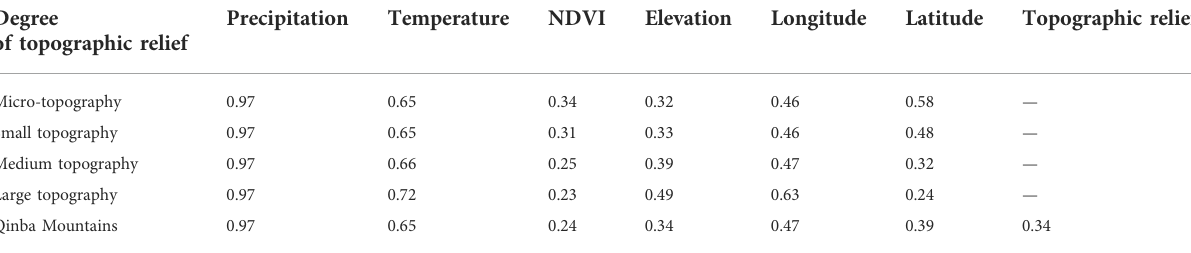
TABLE 2 Statistical results of q values of in fl uencing factors of rainfall erosivity in Qinba Mountains. Degree Precipitation Temperature NDVI Elevation Longitude Latitude Topographic relief of topographic relief Micro-topography — Small topography — Medium topography — Large topography — Qinba